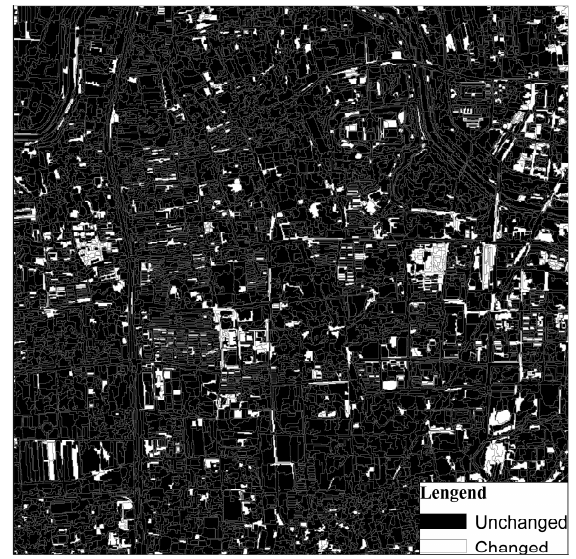
Figure 16. Change binary map for land cover detection based on the object-level double constrained change detection (ODCD). Sensors 2019 , 19 , x